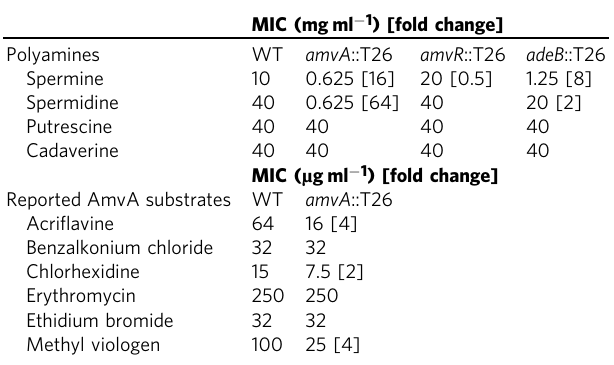
substrates — acri fl avine, chlorhexidine and methyl viologen —